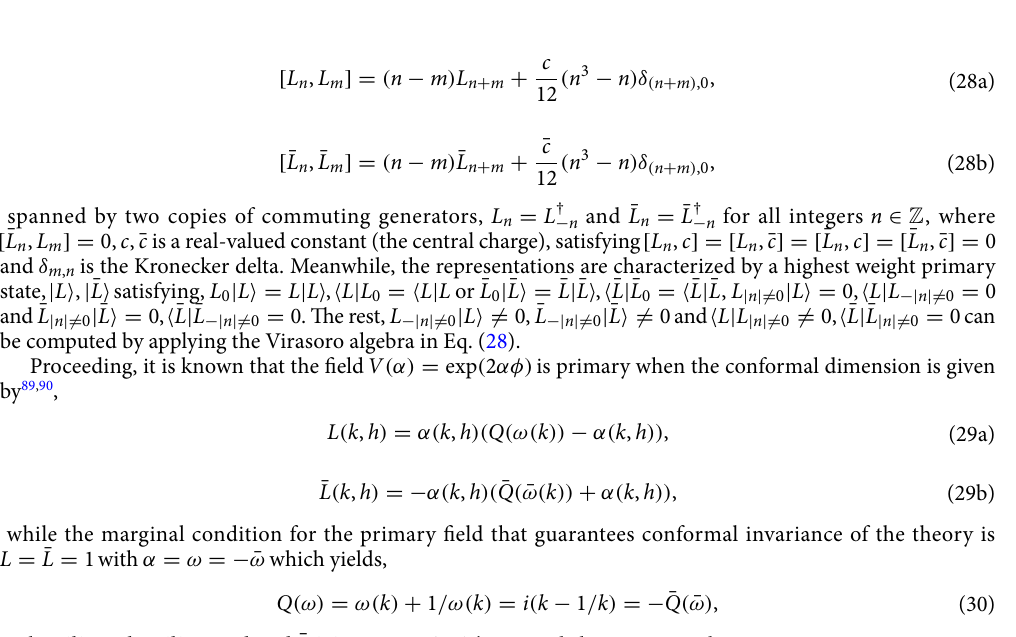
Figure 5. The honeycomb lattice and discrete rotations ( dx / dy on the primitive cell. The primitive cell is rotated as shown in ( a ), ( b ), ( c ) and ( d ) by application of the J 2 transformation, such that J identity matrix, requiring that J